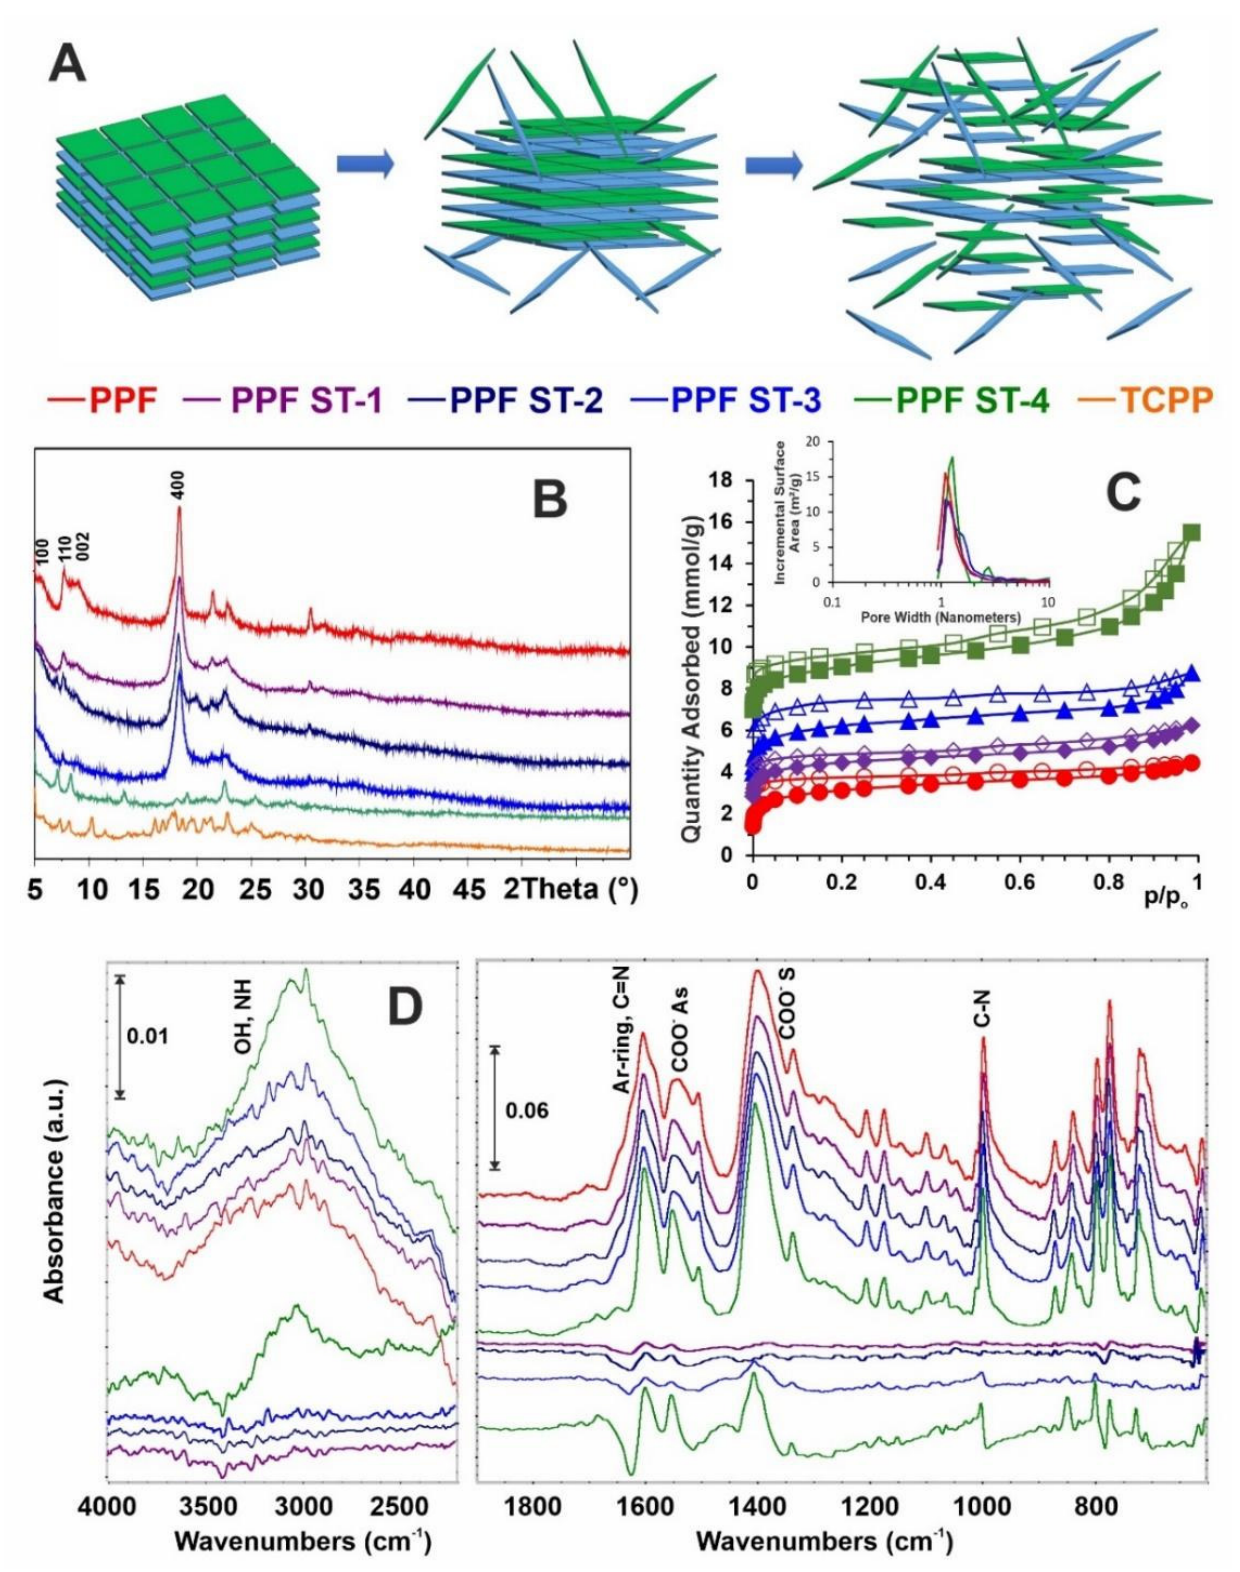
Figure 3. Characteristics of PPF solids remaining after degradation. ( A ) Degradation scheme; ( B ) XRD patterns; ( C ) low temperature N 2 adsorption isotherms (note that isotherms for PPF ST-1, PPF ST-3, PPF ST-4 have been shifted for clarity by 1, 3, and 6 mmol/g, respectively); ( D ) FTIR analysis results.